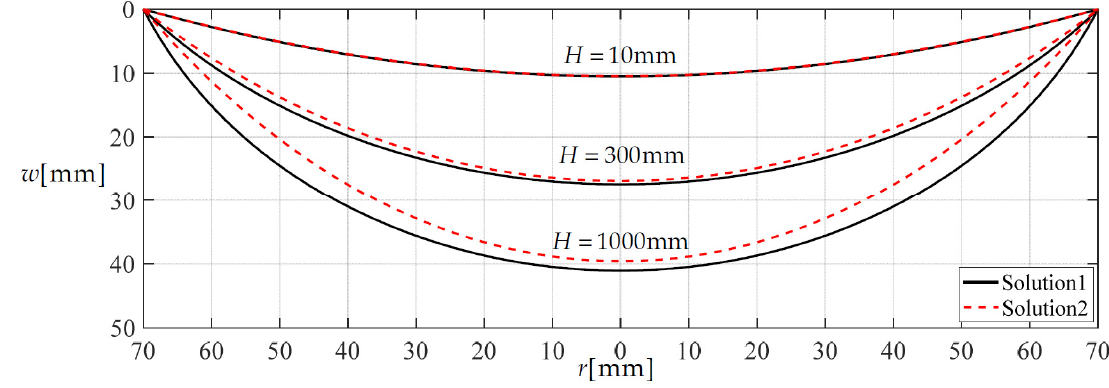
Figure 7. The variations of w with r when H takes 10, 300 and 1000 mm, respectively.